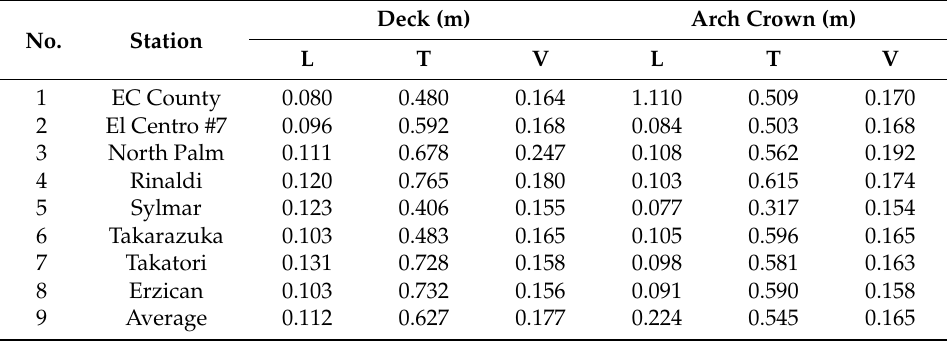
Table 4. Maximum displacement values at deck and arch crown for near-field earthquakes.